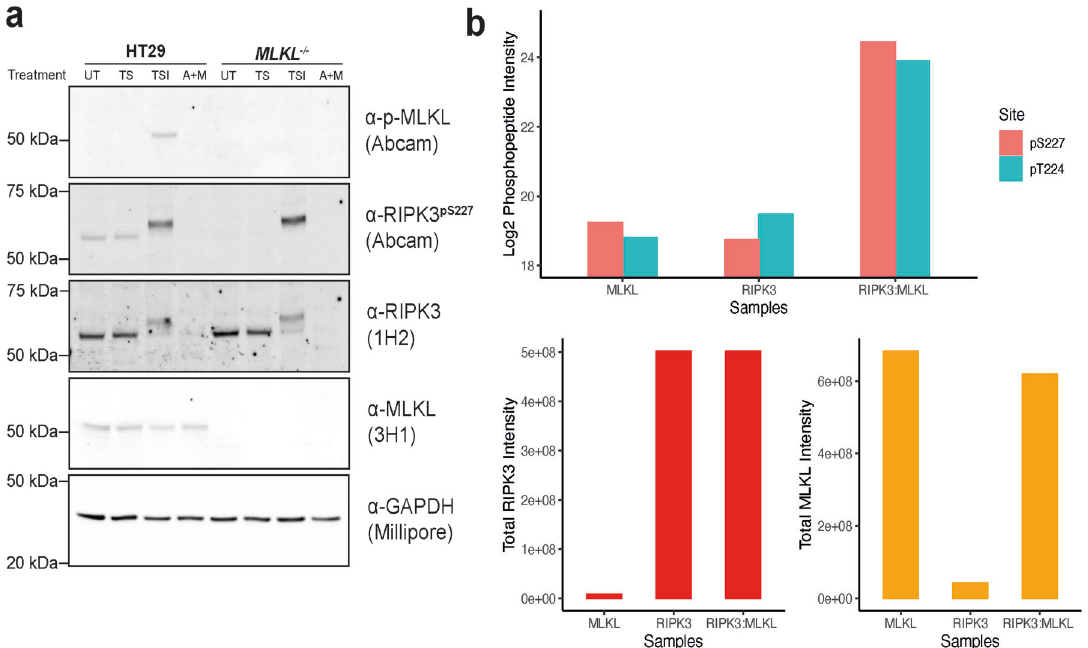
Fig. 4 Human RIPK3 S227 autophosphorylation is dependent on the presence of MLKL. a Evaluation of endogenous RIPK3 S227 autophosphorylation in parental and MLKL − / − HT29 cells. Cells were either left untreated (UT), treated with an apoptotic stimulant (TS; T,